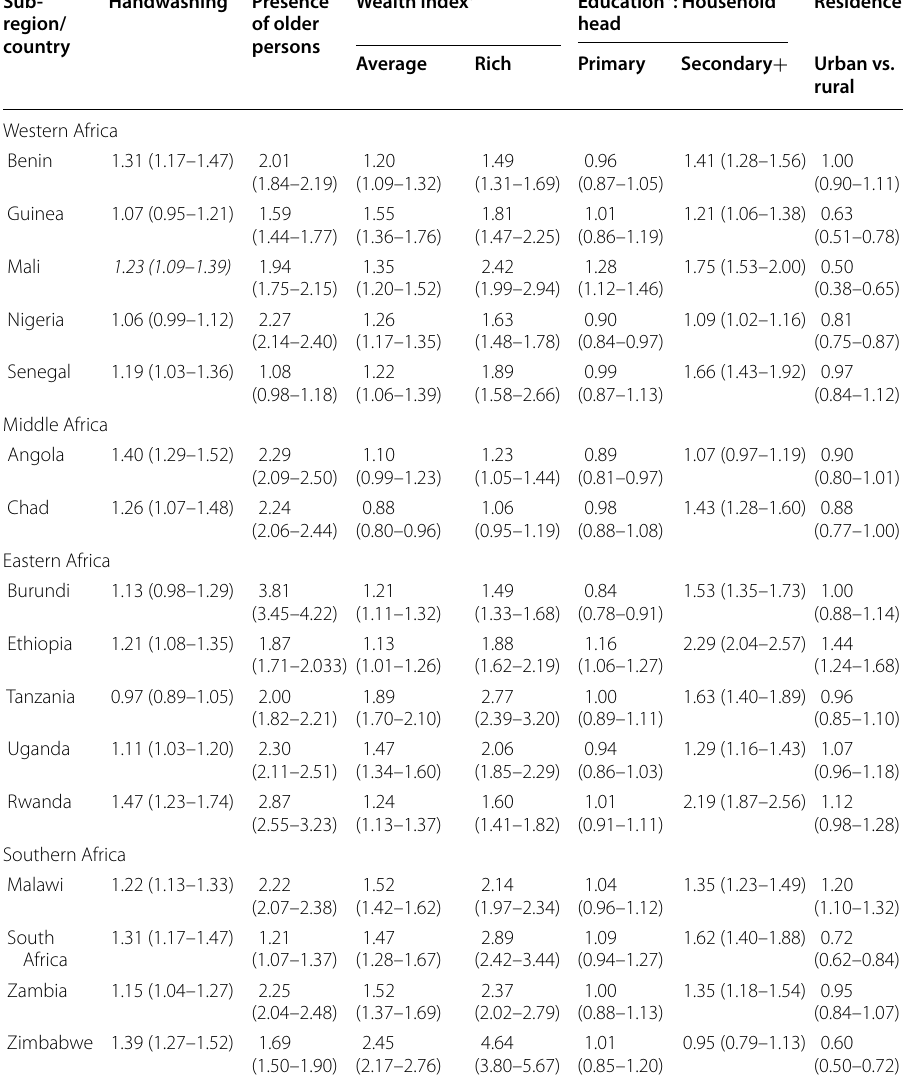
Table 4 Adjusted Odds Ratio (OR) for association between household characteristics and isolation capacity in selected African